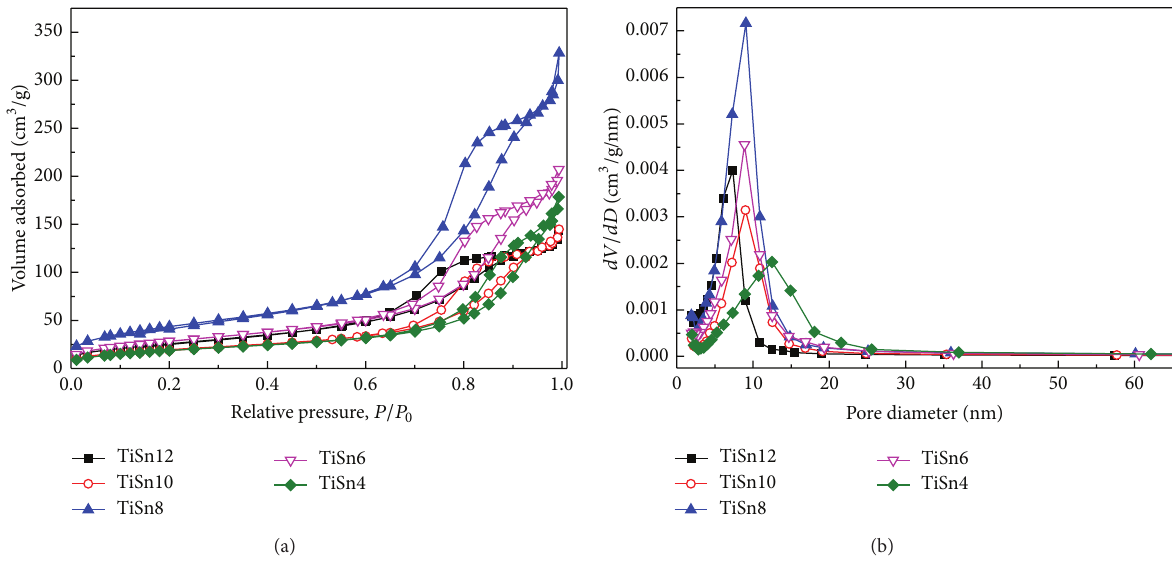
Figure 4: (a) N 2 adsorption-desorption isotherms and (b) the corresponding pore size distribution curves of the prepared samples: TiSn4, TiSn6, TiSn8, TiSn10, and